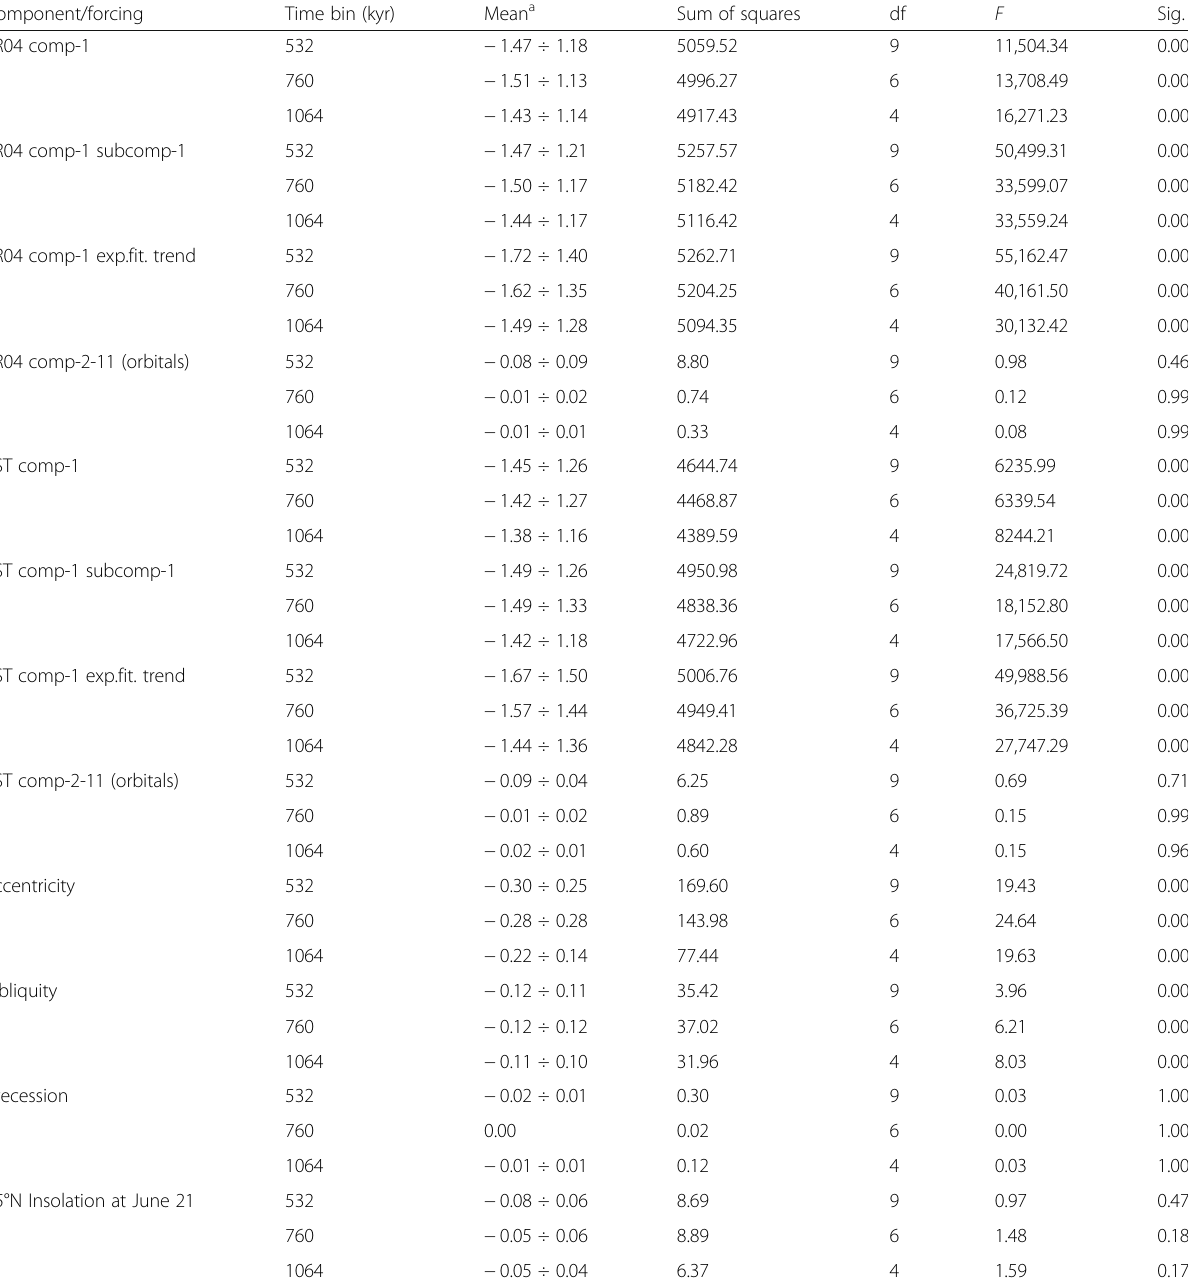
Table 7 Significance tests of the mean differences among δ 18 O and SST components and the solution of orbital forcings (Laskar et al. 1993) binned at three arbitrary constant time intervals (532 kyr, 760 kyr, and 1064 kyr). Data standardized on the entire Plio-Pleistocene record (mean = 0, standard deviation = 1) and, where necessary, inverted to have the same paleoclimatic polarity (positive values for positive forcing and